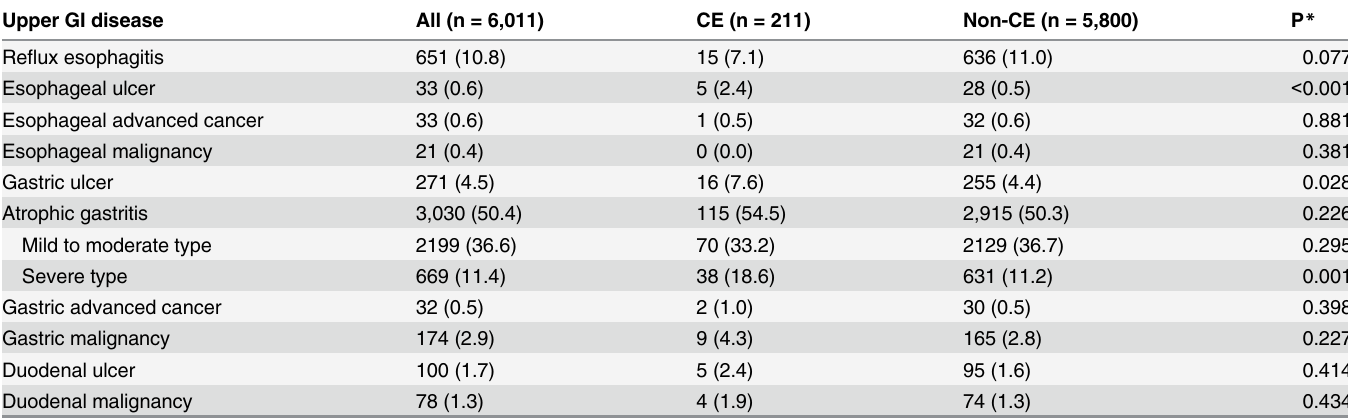
Table 2. Upper gastrointestinal diseases concomitant with candida esophagitis evaluated by endoscopy with pathology. Upper GI